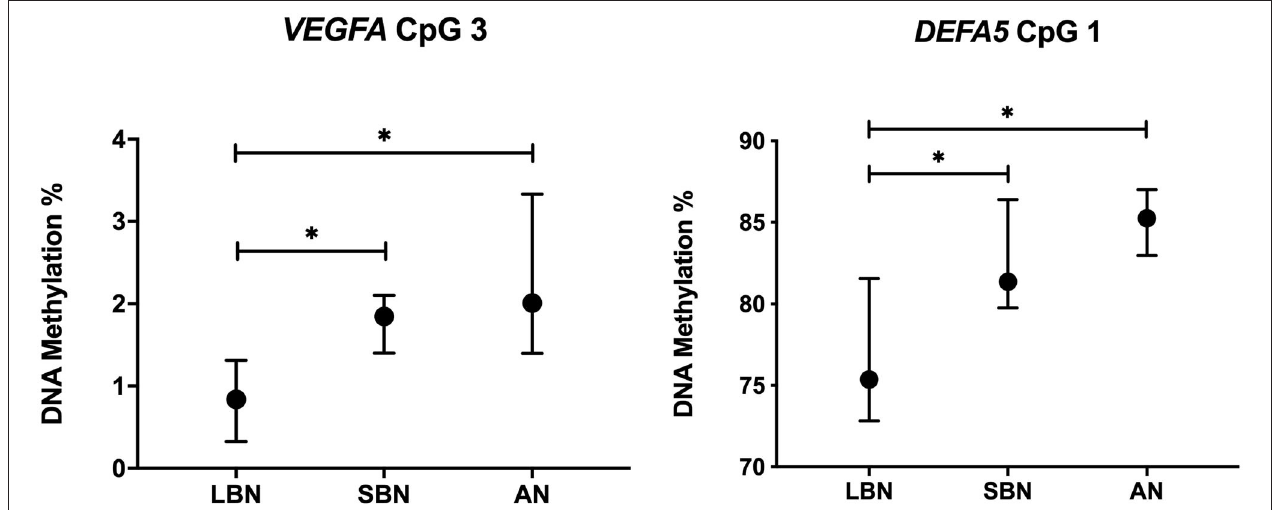
FIGURE 3 | DNA methylation long before, a short time before and after NEC onset of VEGFA CpG 3 and DEFA5 CpG 1. Presented as median and IQR. * = P < 0.05. LBN, Long Before NEC, SBN, a Short time Before NEC; AN, After NEC; NEC, Necrotizing